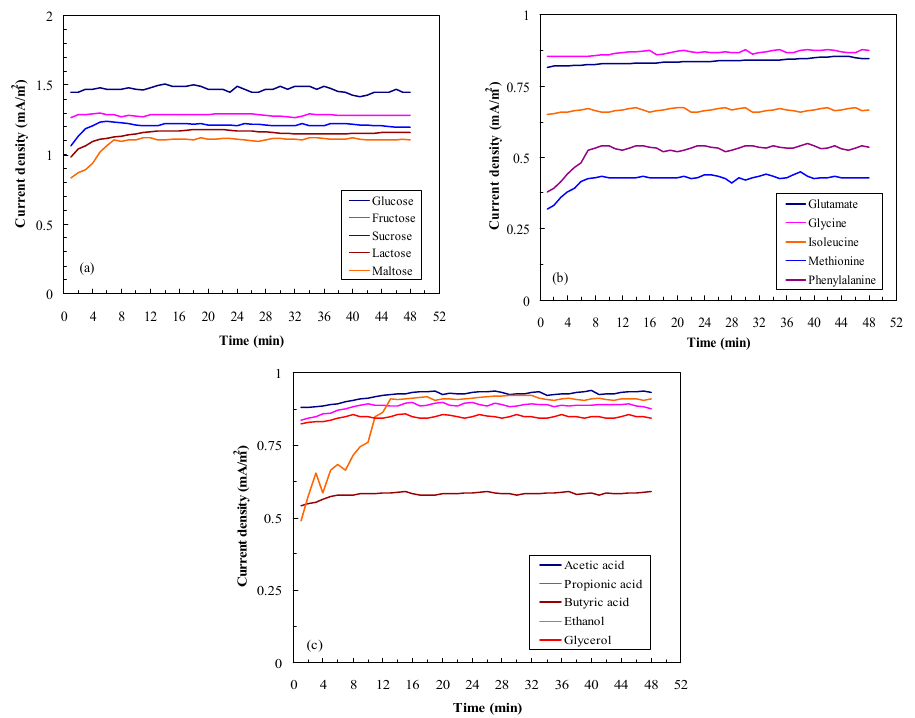
Figure 2. Effects of different substrates on the MFC performance. ( a ) Carbohydrates; ( b ) Amino acids; ( c ) Acids and alcohols (substrate concentration: 100 mg/L; LRT: 4 h; GRT: 6 min; n = 3).